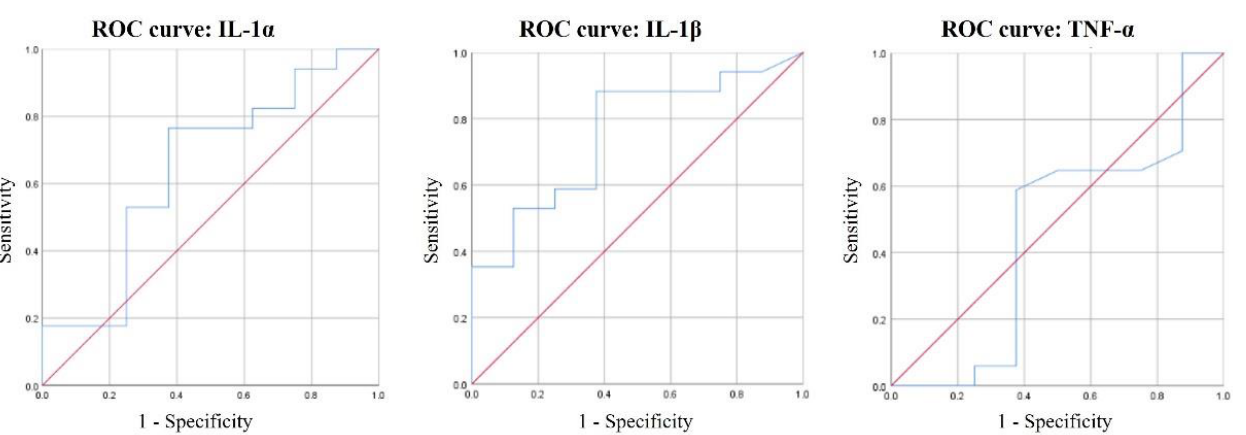
α , IL-1 β , and TNF- α for periodontal disease Figure 2. ROC curves of IL-1α, IL-1β, and TNF-α for periodontal disease diagnosis. Figure 2. ROC curves of IL-1